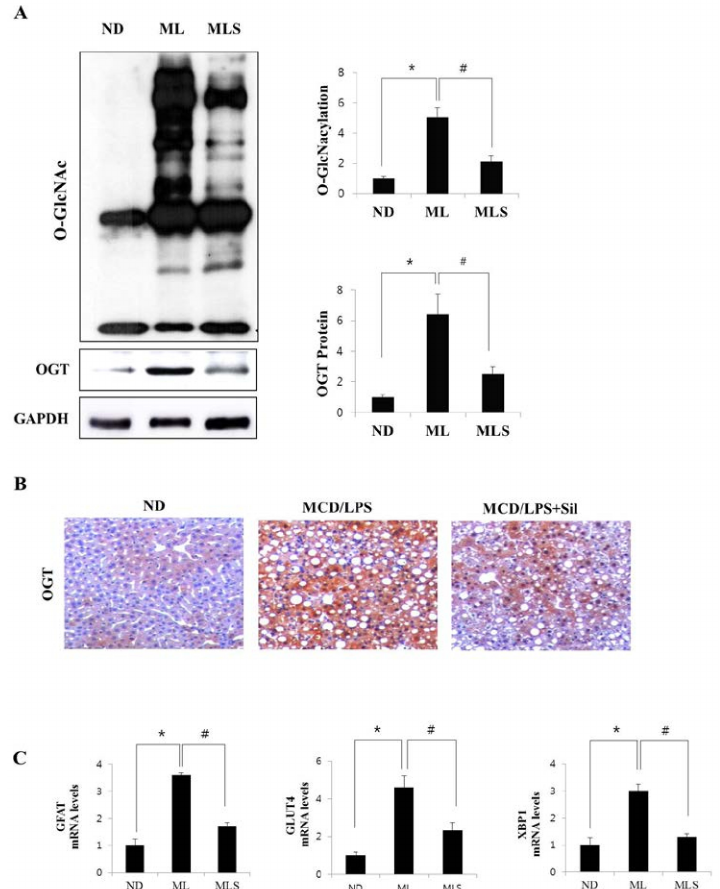
Figure 3. O -GlcNAcylation and the expression levels of the proteins associated with the HBP pathway. ( A ) The upper panel shows the hepatic expression levels of O -GlcNAcylation in ND, MCD/LPS, or MCD/LPS + silibinin groups. The middle and lower panels represent the relative expression levels of OGT and GAPDH, respectively, as observed by immunoblotting. In the two graphs on the right, the intensity of O -GlcNAcylation and OGT was determined by densitometry. Data are representative of three independent experiments. ( B ) Liver sections of ND, MCD/LPS, or MCD/LPS + silibinin-fed mice were subjected to immunohistochemical analysis with antibodies against OGT. × 200 magnification. ( C ) Relative expression levels of the proteins associated with the HBP pathway were determined by qRT-PCR analysis. Differential levels of GFAT , GLUT4 , and XBP1 mRNA are shown as fold-increase. Gene expression was normalized to 18 s RNA as an internal standard, and the data were presented as the mean value ± SE of seven samples. * p < 0.05 vs. ND group, and # p < 0.05 vs. MCD/LPS